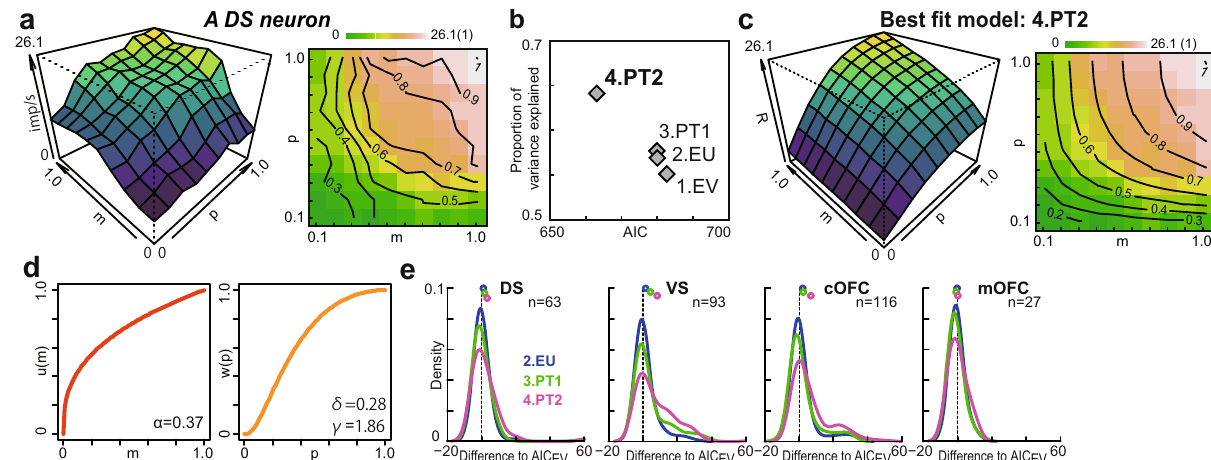
Fig. 4 | Prospect theory best explained neural fi ring rates in the reward cir- cuitry. a Plot of an example activity of the DS neuron in Fig. 2b against the prob- ability ( p ) and magnitude ( m ) of rewards. To draw the 3D curvature (left) and contour lines (right), the neighboring pixels were averaged and smoothed. b AIC values against the proportion of variance explained are plotted in each model